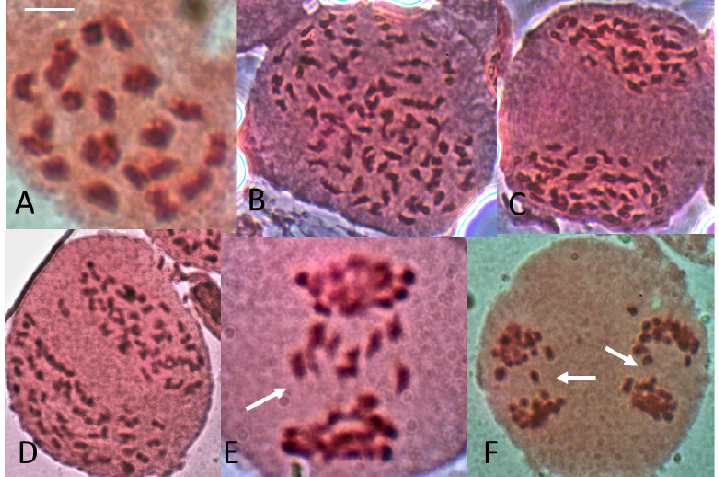
Fig. 3. Stages of cell division in P. angulata x P. pubescens F1 hybrid (Scale = 1.8 µm); A. Metaphase I (showing 18 II); B. Complete univalent (36 I) in metaphase II; C. Unpaired chromosomes in anaphase I (no laggard); D. Unequal distribution of chromosome in anaphase I (the pole at the bottom has more chromosomes than at the one at the top); E. Multiple laggards in anaphase I (arrowed); F. Laggard chromosomes in anaphase